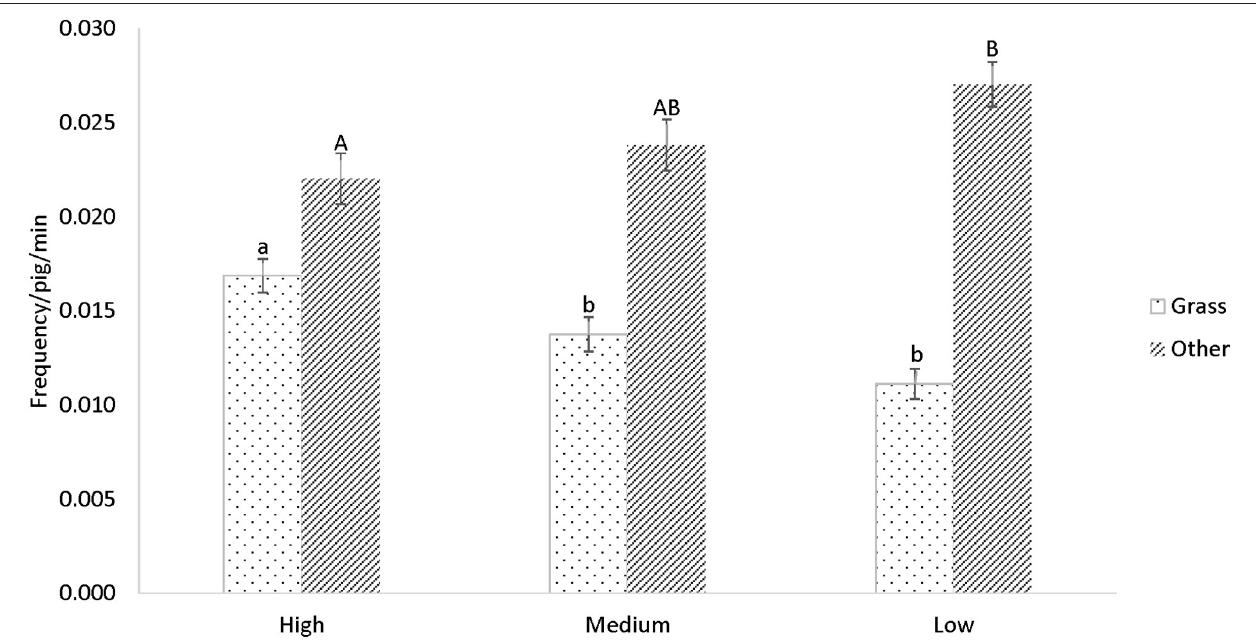
FIGURE 4 | Mean ( ± s.e.) frequency of interaction with grass and all other items between treatments in the weaner stage. Different small letters denote differences in grass interaction ( P < 0.001), and capital letters denote differences in interactions with other items between treatments ( P = 0.02). Differences were indicated after Tukey-Kramer adjustment.